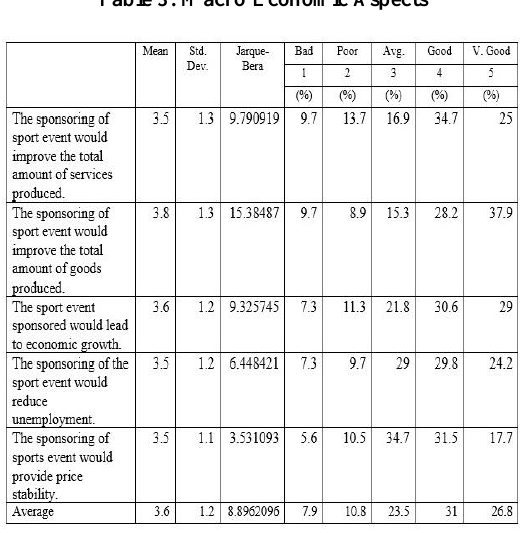
Table 3: Macro-Economic Aspects